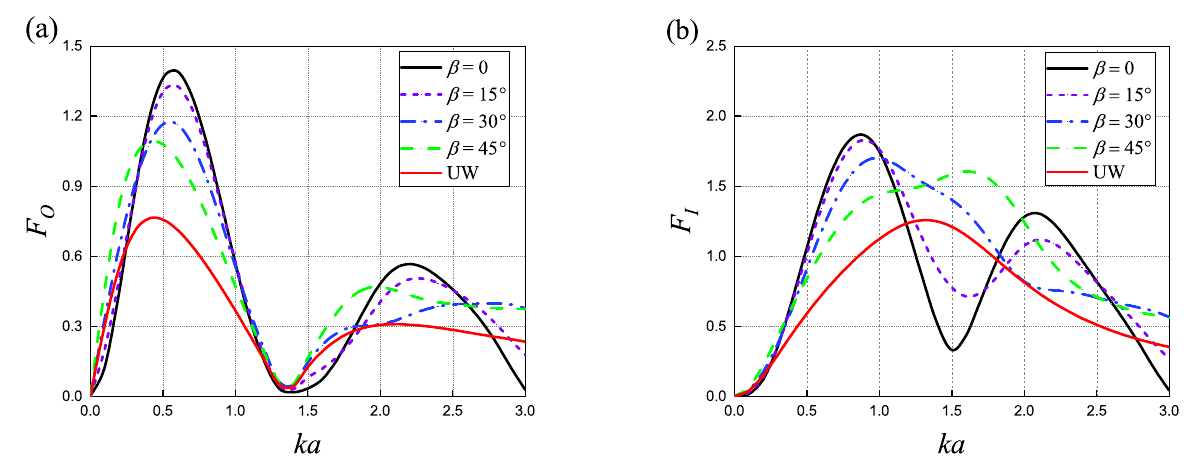
Figure 5. Hydrodynamic forces on the outer and inner cylinders versus ka for four wave incident angles β = 0,15 ◦ ,30 ◦ ,45 ◦ with e / a = 1, c / a = 0.5, h / a = 1.5, and G 1 = G 2 = 1 : ( a ) the outer cylinder, ( b ) the inner cylinder.